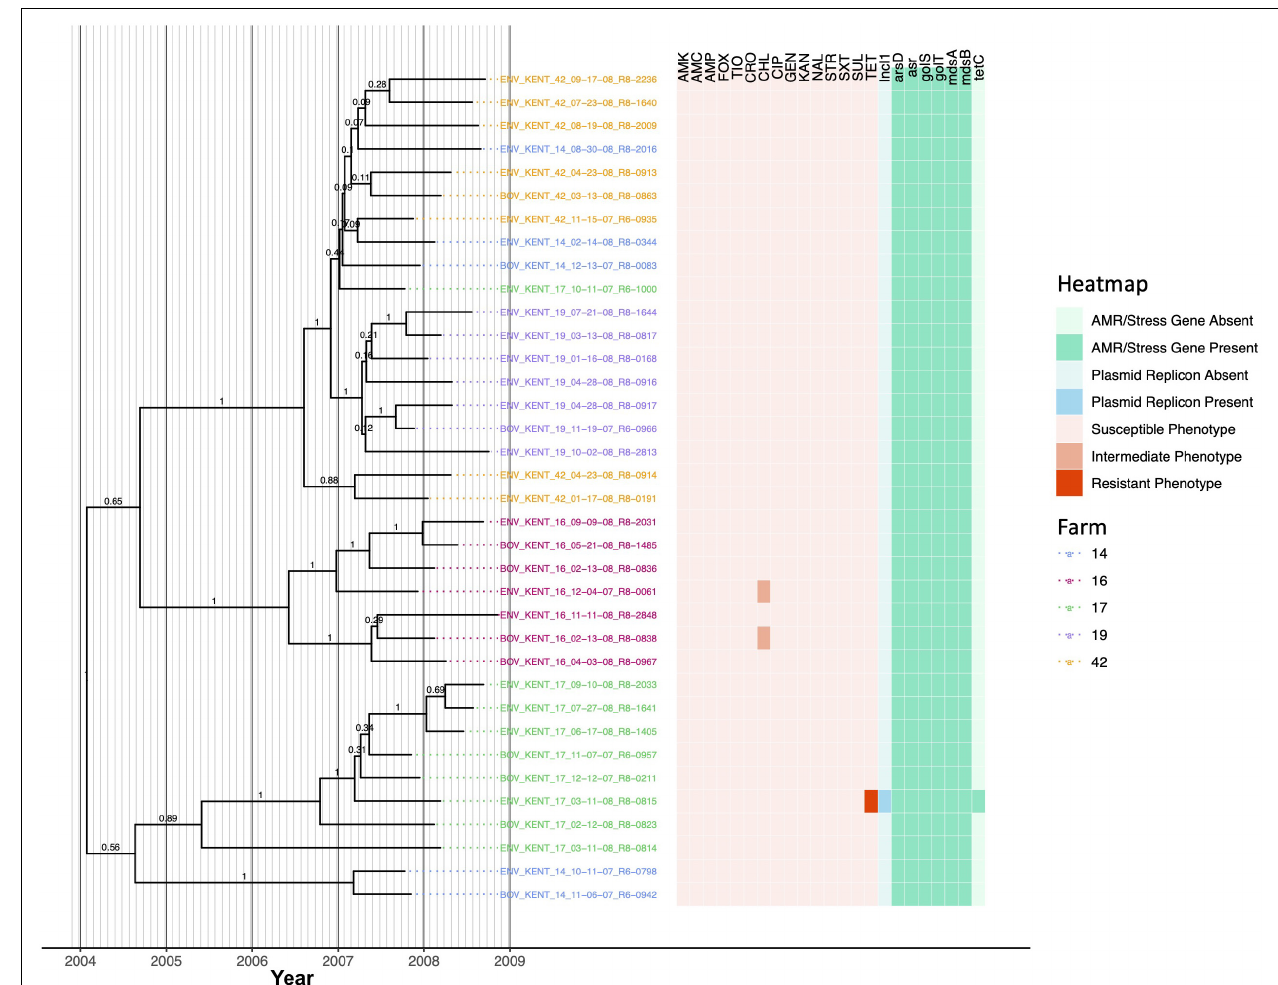
FIGURE 7 | Rooted, time-scaled maximum clade credibility (MCC) phylogeny constructed using core SNPs identified among 36 Salmonella Kentucky genomes isolated from subclinical bovine sources and the surrounding bovine farm environment. Tip label colors denote the ID of the farm from which each strain was isolated. Branch labels denote posterior probabilities of branch support. Time in years is plotted along the X -axis, and branch lengths are reported in years. The heatmap to the right of the phylogeny denotes (i) the susceptible-intermediate-resistant (SIR) classification of each isolate for each of 15 antimicrobials (obtained using phenotypic testing and NARMS breakpoints; orange); (ii) presence of plasmid replicons (detected using ABRicate/PlasmidFinder and minimum nucleotide identity and coverage thresholds of 80 and 60%, respectively; blue); (iii) presence of antimicrobial resistance (AMR) and stress response genes (identified using AMRFinderPlus and default parameters; green). Core SNPs were identified using Snippy. The phylogeny was constructed using the results of ten independent runs using a relaxed lognormal clock model, the Standard_TVMef nucleotide substitution model, and the Coalescent Bayesian Skyline population model implemented in BEAST version 2.5.1, with 10% burn-in applied to each run. LogCombiner-2 was used to combine BEAST 2 log files, and TreeAnnotator-2 was used to construct the phylogeny using common ancestor node heights. Abbreviations for the 15 antimicrobials are: AMK, amikacin; AMC, amoxicillin-clavulanic acid; AMP, ampicillin; FOX, cefoxitin; TIO, ceftiofur; CRO, ceftriaxone; CHL, chloramphenicol; CIP, ciprofloxacin; GEN, gentamicin; KAN, kanamycin; NAL, nalidixic acid; STR, streptomycin; SXT, sulfamethoxazole-trimethoprim; SUL, sulfisoxazole; TET,